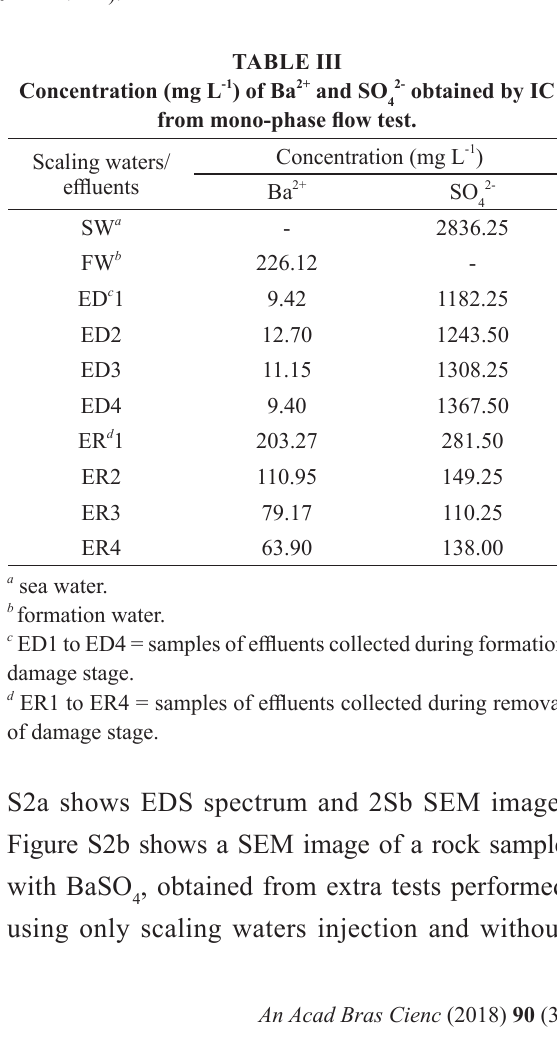
Figure 4 - Measurement of original (k the Darcy law for the mono-phase flow test (15% DTPA/24h).